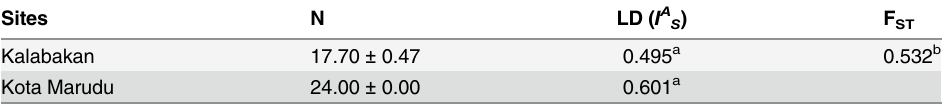
S , index of association; N, number of sample; F I A a Signi fi cant value, p < 0.01. b Signi fi cant value, p <